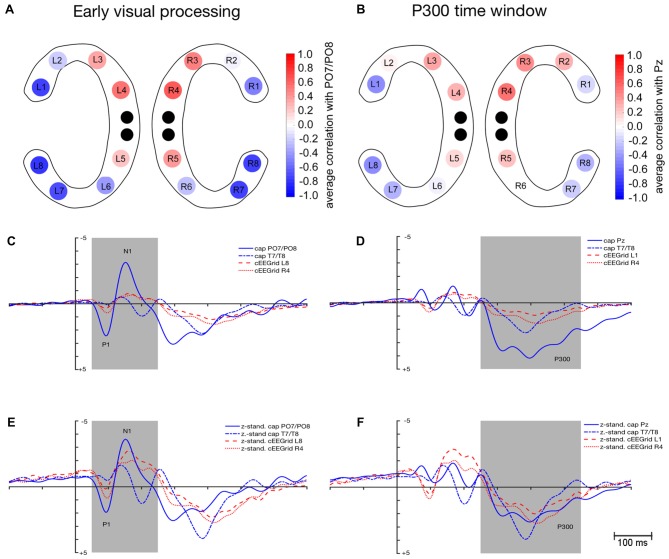
Similarity in event-related potential (ERP) waveform morphology between ERPs extracted from cEEGrid-EEG and cap-EEG for the early visual processing (50–250 ms) and P300 time window (250–550 ms). (A) Color-coded average correlations (p ≤ 0.05) between mean activity at each cEEGrid electrode and at cap PO7/PO8. (B) Color-coded average correlations (p ≤ 0.05) between mean activity at each cEEGrid electrode and at cap Pz. (C) Grand-average ERPs as recorded from cap PO7/PO8, cap T7/T8 (inverse), cEEGrid L8 (inverse) and cEEGrid R4. (D) Grand-average ERPs as recorded from cap Pz, cap T7/T8 (inverse), cEEGrid L1 (inverse) and cEEGrid R4. (E)
z-standardized grand-average ERPs as recorded from cap PO7/PO8, cap T7/T8 (inverse), cEEGrid L8 (inverse) and cEEGrid R4. (F)
z-standardized grand-average ERPs as recorded from cap Pz, cap T7/T8 (inverse), cEEGrid L1 (inverse) and cEEGrid R4. Black dots in (A,B) represent reference and ground electrodes of the cEEGrids. Shaded areas in (C–F) represent time windows for which similarity between ERPs extracted from the cap- and the cEEGrid-EEG was analyzed.